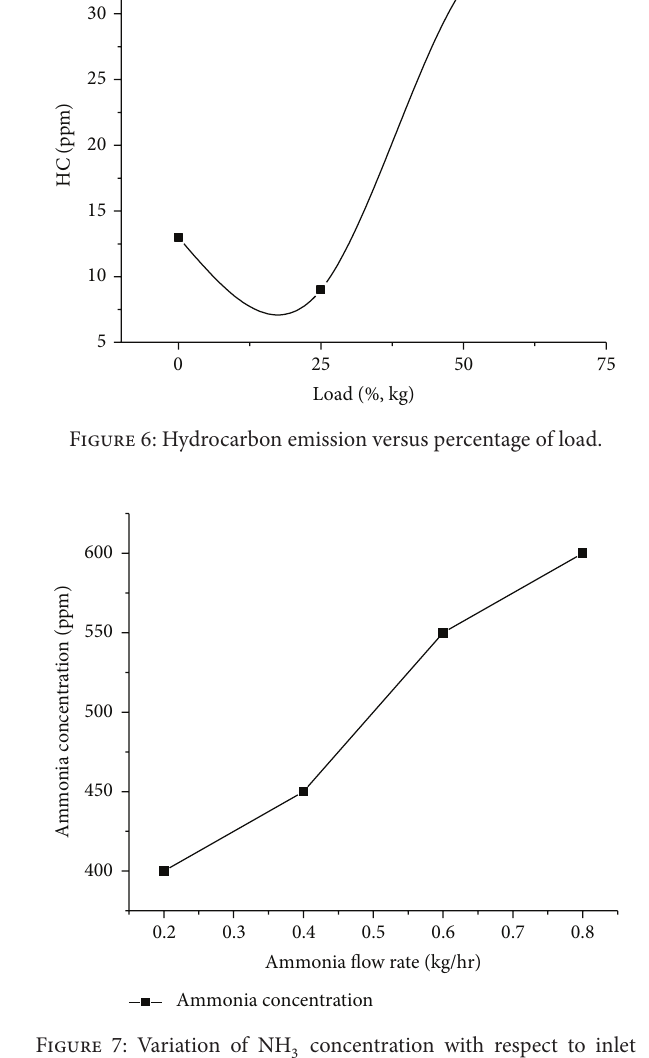
Figure 7: Variation of NH 3 concentration with respect to inlet ammonia flow